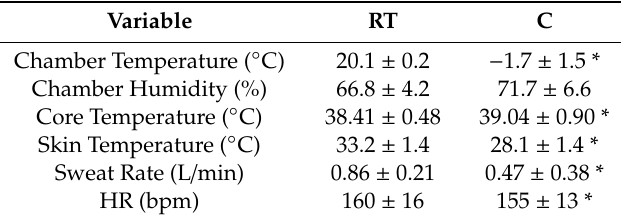
Table 3. Exercise Trial Data.